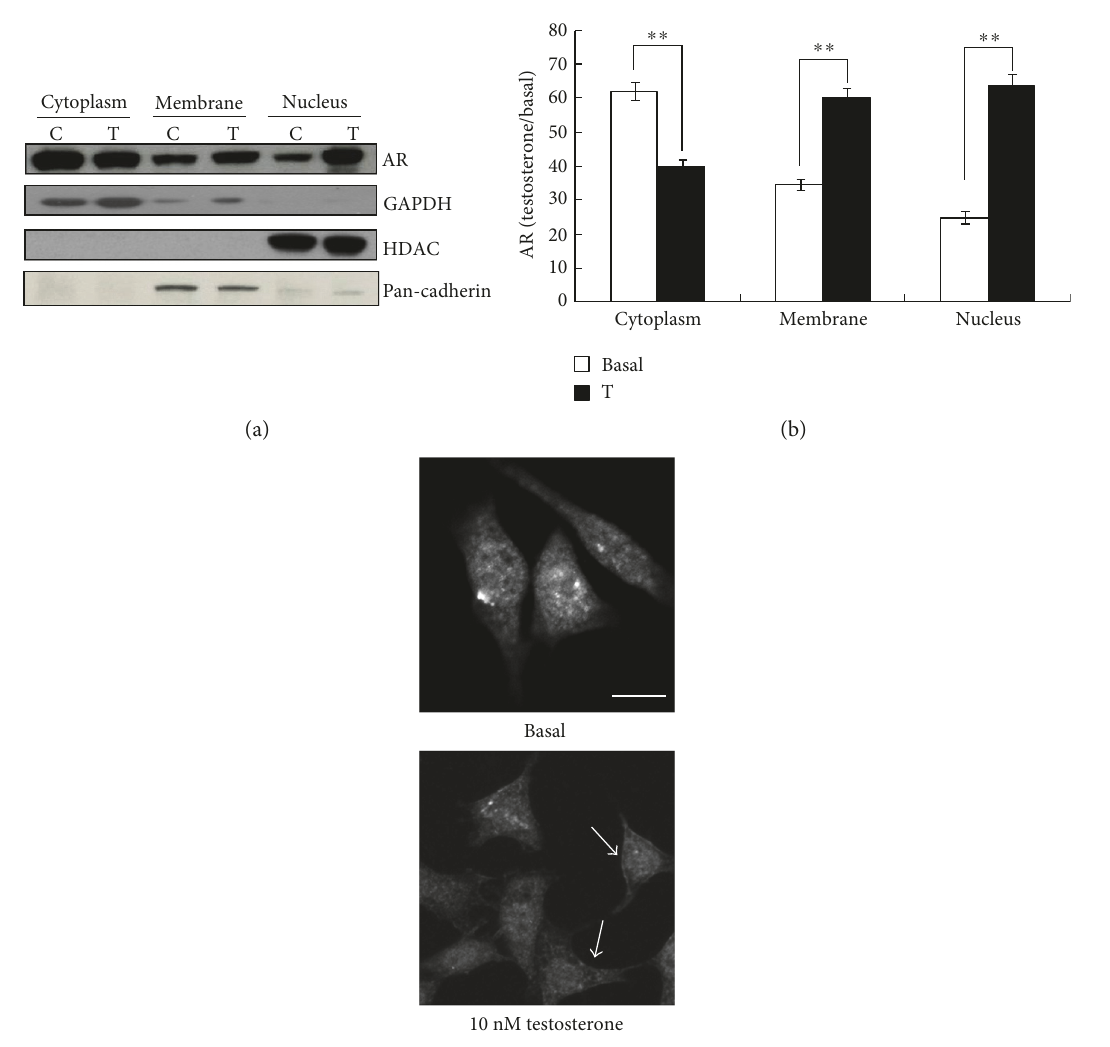
Figure 1: Testosterone induced membrane association of AR. (a) Representative Western blot analysis of AR levels in cytoplasmic, membrane, and nuclear proteins from cells incubated for 30min with vehicle (control (C)) or 10nM testosterone (T). (b) Semiquantitative analysis of AR levels in the subcellular fractions after exposure of the cells to vehicle (basal) or testosterone for 30 min. Data were expressed as the mean and SEM of the ODs of the AR band, multiplied by the testosterone-to-basal ratio of the respective mark proteins, GAPDH, HDAC, and pan-cadherin for cytoplasmic, nuclear, and membrane fractions. ∗∗ P < 0 01 compared with that of the respective basal ( n = 5 ). Confocal microscopy imaging of the e ff ect of testosterone on AR tra ffi cking. Cells were incubated with 10 nM testosterone for 30 min, before fi xation and confocal microscopy examination. Bar=50 μ